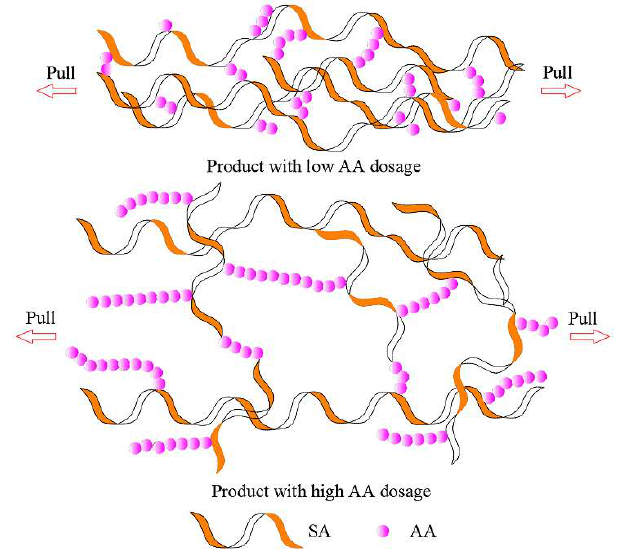
Figure 2. Microcosmic model of product in tension test [34].